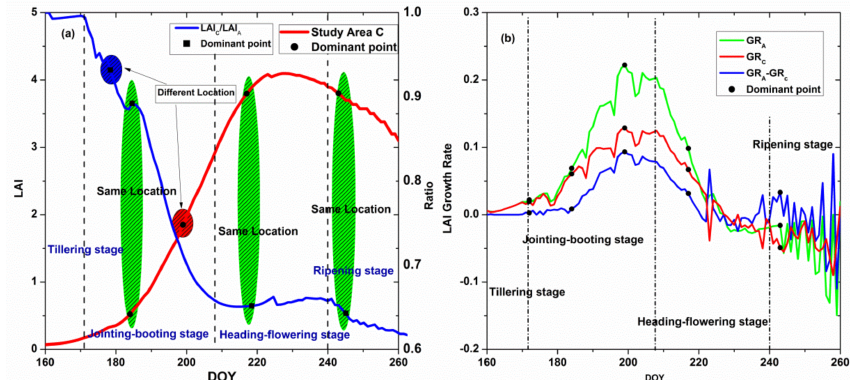
Figure 9. Dynamic assessment of the variations of LAI under heavy metal stress with the dominant points. ( a ) The locations of the dominant points in the original LAI curve and ratio curve: green areas represent the same location of the points; blue and red areas showed the different locations in the two kinds of curves; ( b ) the locations of the all dominant points in growth rate of rice roots (GR) for Area A, Area C and the differences between two